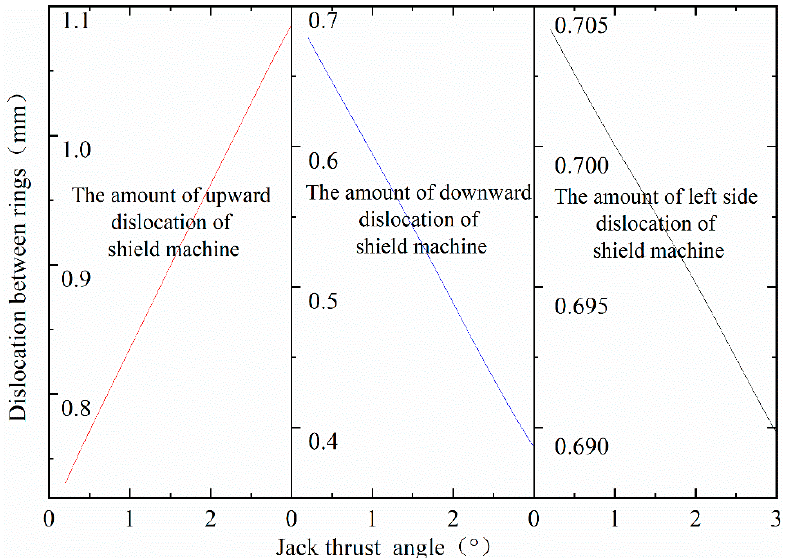
Figure 15. Maximum dislocation of circumferential joint.